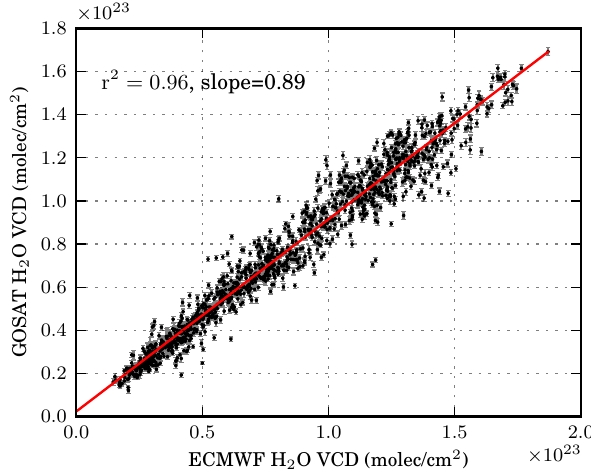
Fig. 6. Comparison of single soundings of GOSAT H 2 O with ECMWF analysis data (used as prior). The error bars for the H 2 O column retrieval are multiplied by 2.5 to make them visible (and are now roughly equivalent to the error in the HDO column retrieval, which is on average about 2.5 times higher than that for H 2